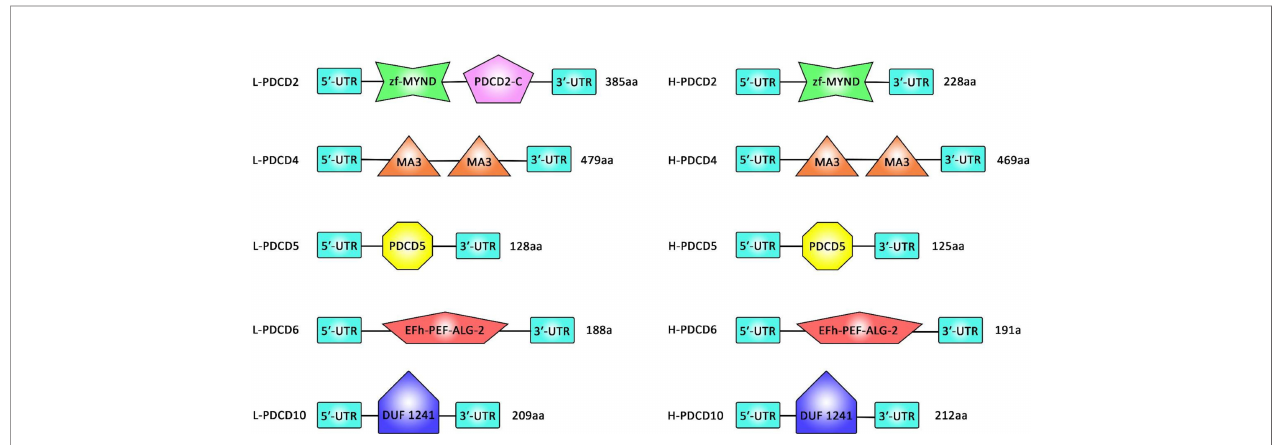
FIGURE 1 | A comparison between the sequence of the domains of PDCD family genes (PDCD2, PDCD4, PDCD5, PDCD6, and PDCD10) in Lamprey and